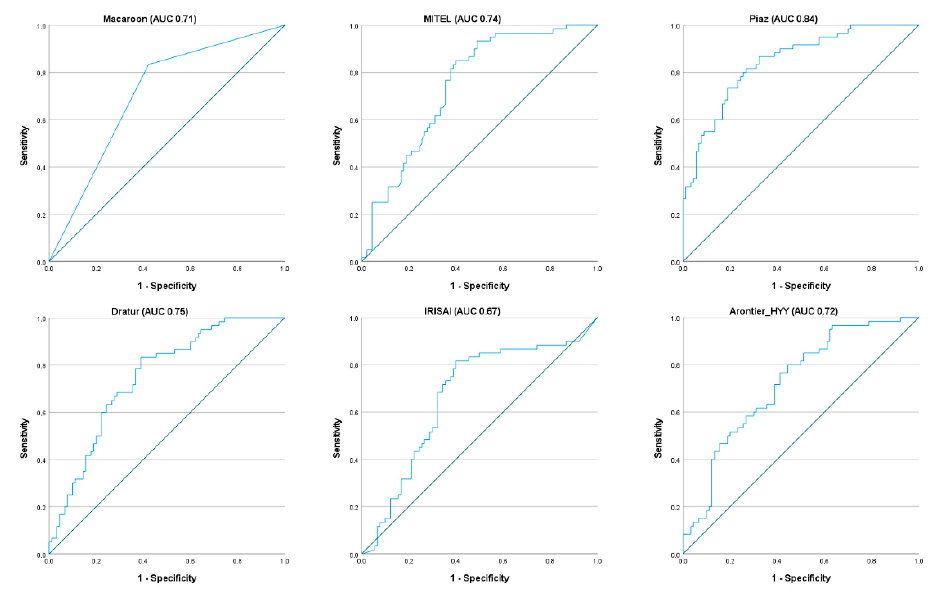
Figure 8. ROC curves for the methods proposed by the six best teams in the test dataset.